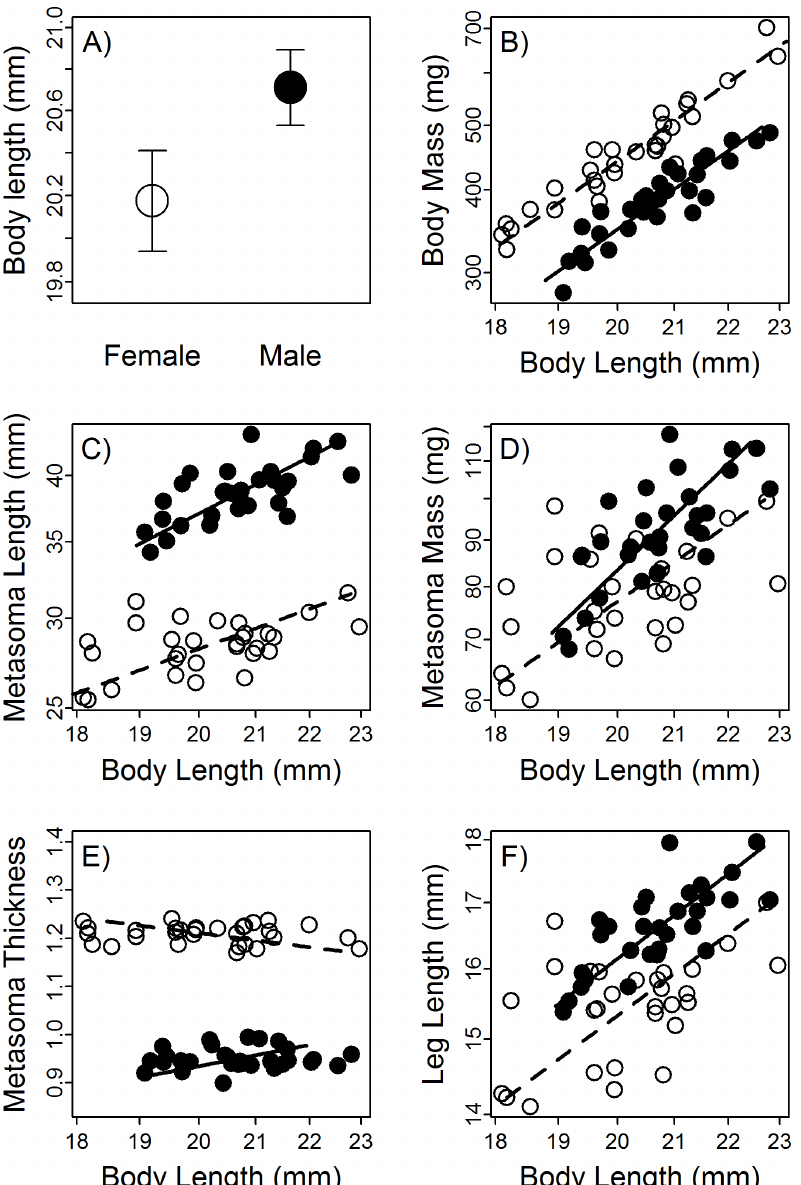
Figure 2. Morphological differences between female (open circles) and male (filled circles) C.vittatus scorpions. B–F depict allometric scaling relationships of traits with body length, and lines represent the fitted relationship within each sex. Metasoma thickness (E) was calculated as metasoma mass (transformed by the inverse-power of its scaling relationship with length) divided by metasoma length. Scales are all logarithmic, except for relative metasoma